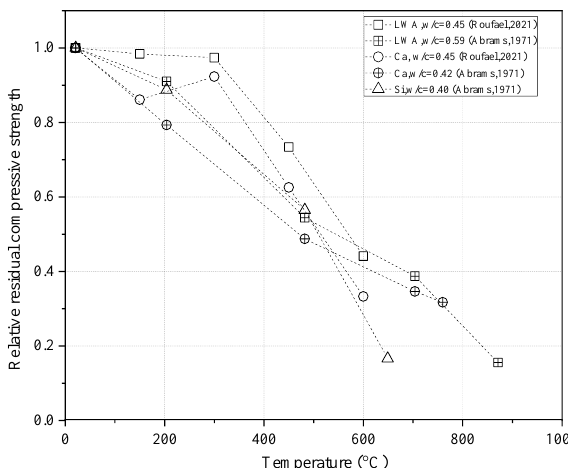
Figure 14. The relative residual compressive strength of concrete containing different aggregate types: lightweight aggregate (LWA), calcareous (Ca) and siliceous (Si) aggregate [78,79].